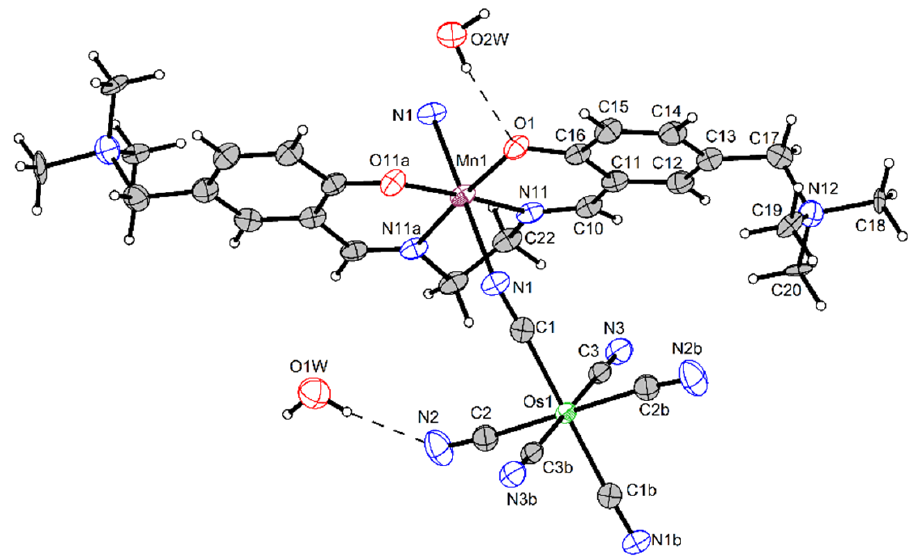
Figure 1. ORTEP view of the structure of 1 , showing the atom-labeling scheme. Displacement ellipsoids are drawn at the 50% probability level.